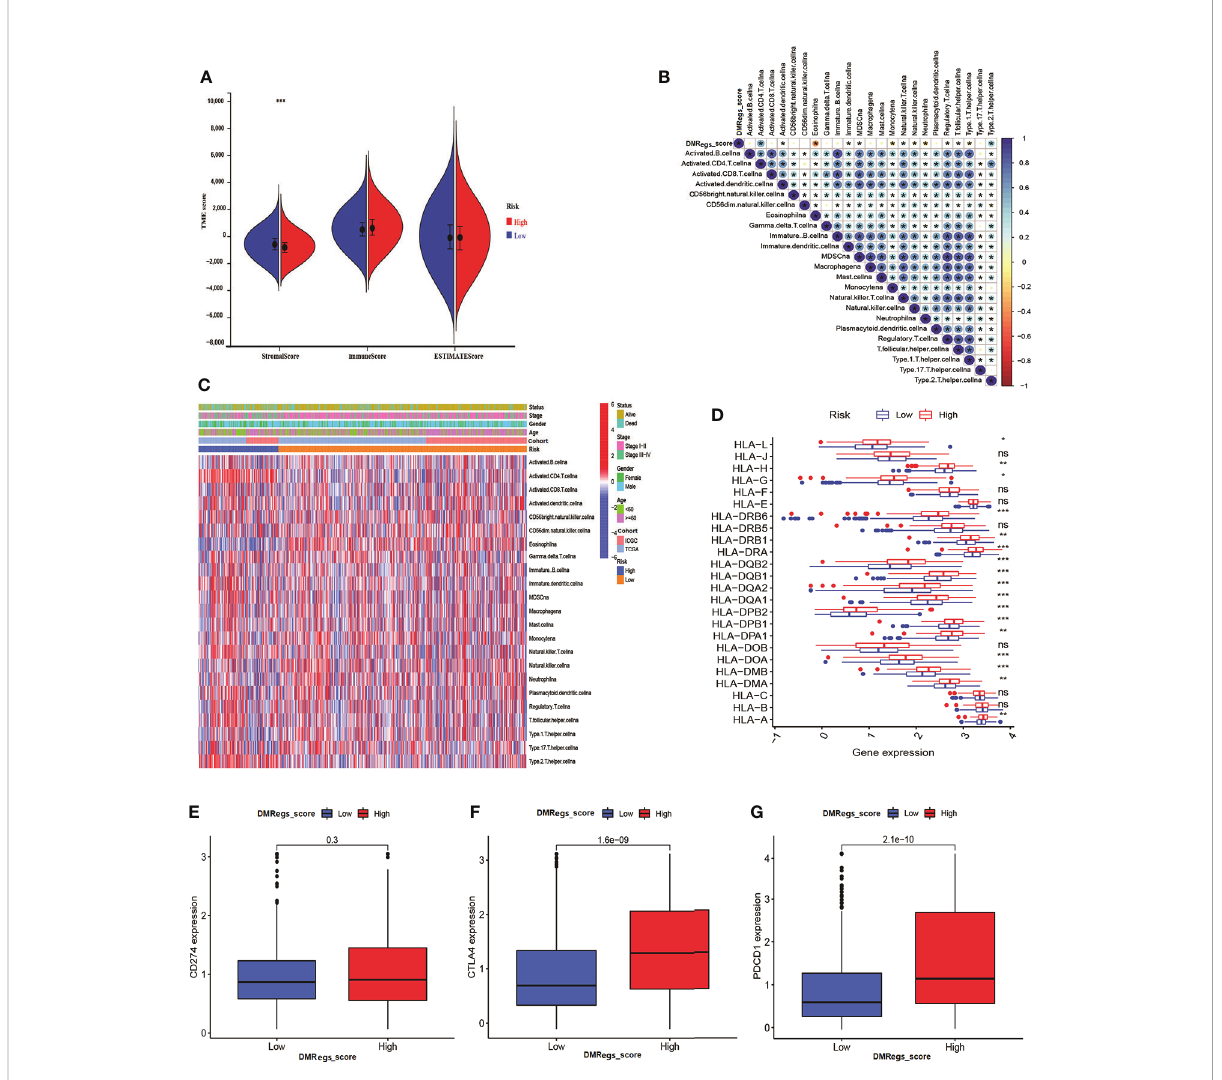
FIGURE 7 The immune cell in fi ltration characteristics of DMRegs_score in HCC patients. (A) The differences of TME score in the two risk groups. (B) The relationship of DMRegs_score and 23 types of immune cells in fi ltration. (C) The landscape of immune cells in fi ltration of DMRegs_score in patients with different clinicopathological features. (D) The expression differences of HLA-related genes between two risk group. (E – G) The expression level of CD274, CTLA4 and PDCD1 in two risk groups. * P < 0.05, ** P < 0.01, *** P < 0.001, **** P < 0.0001. ns, no signi fi